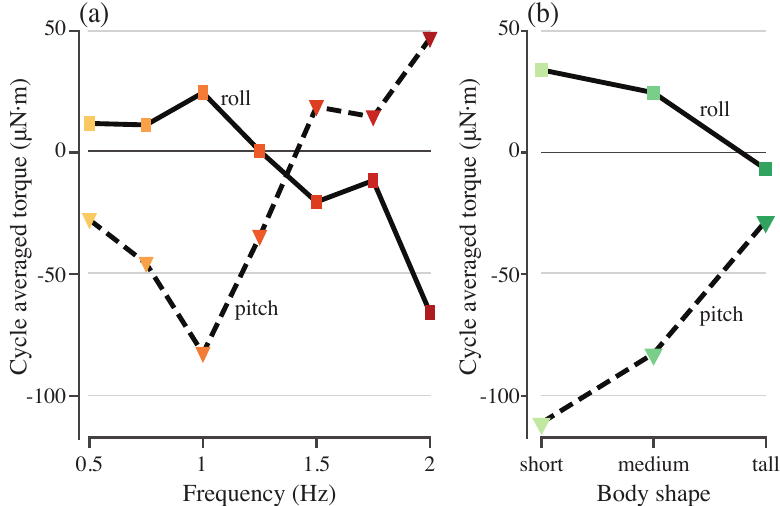
Figure 6. Pitch and roll torques needed to stabilize models with different driving frequencies ( a ) and different body shapes ( b ).